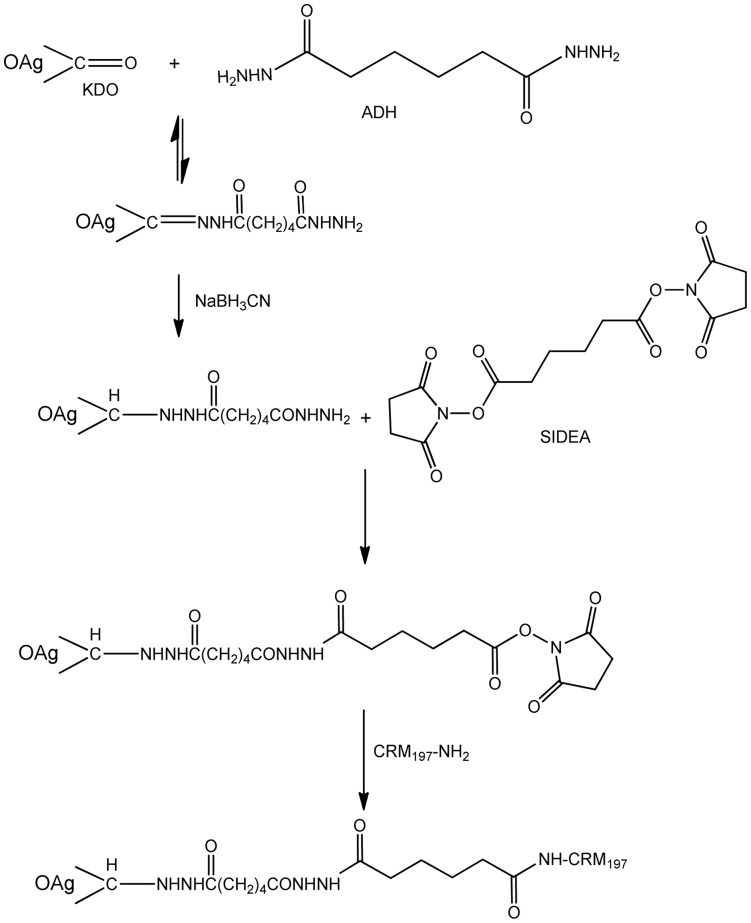
O:2-ADH-SIDEA-CRM197 conjugation scheme.Same reaction was also performed with the shorter linker CDH instead of ADH.